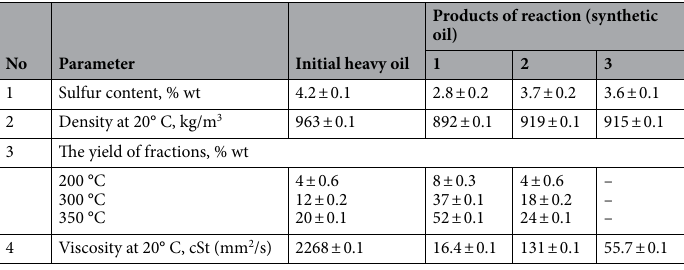
Table 3. Parameters of raw materials and synthetic oils.